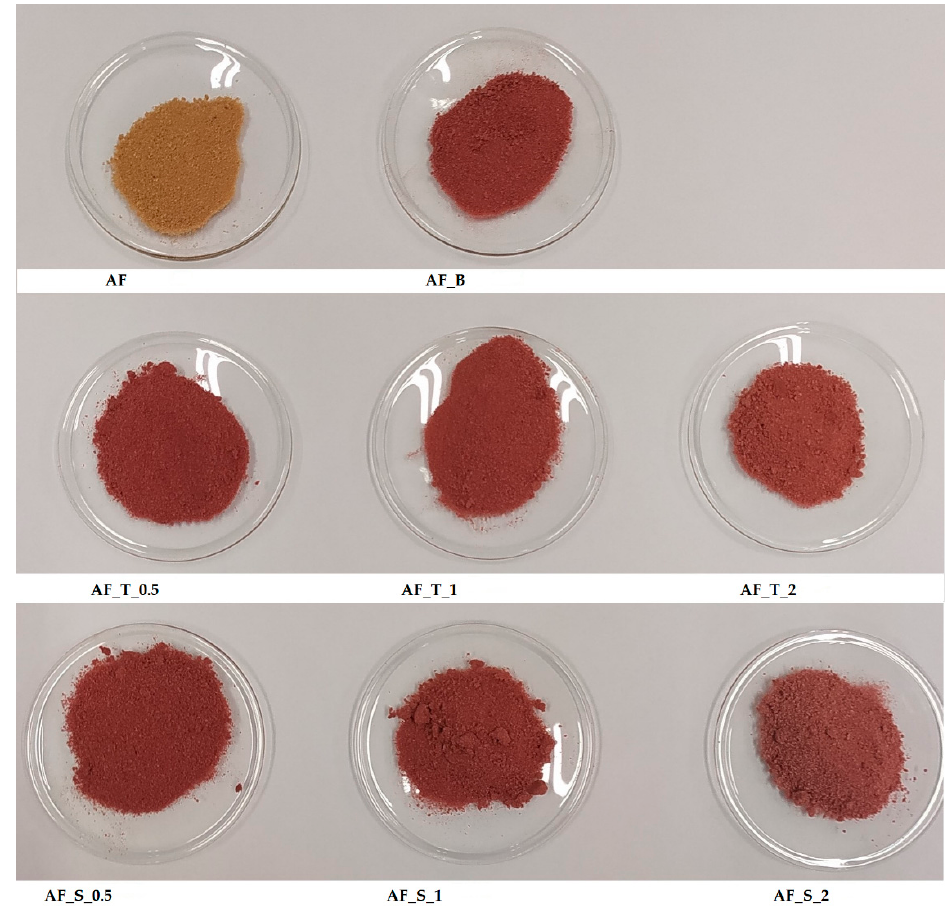
Figure 1. Presentation of formulated microparticles. AF_B—apple fiber/blackberry microparticles